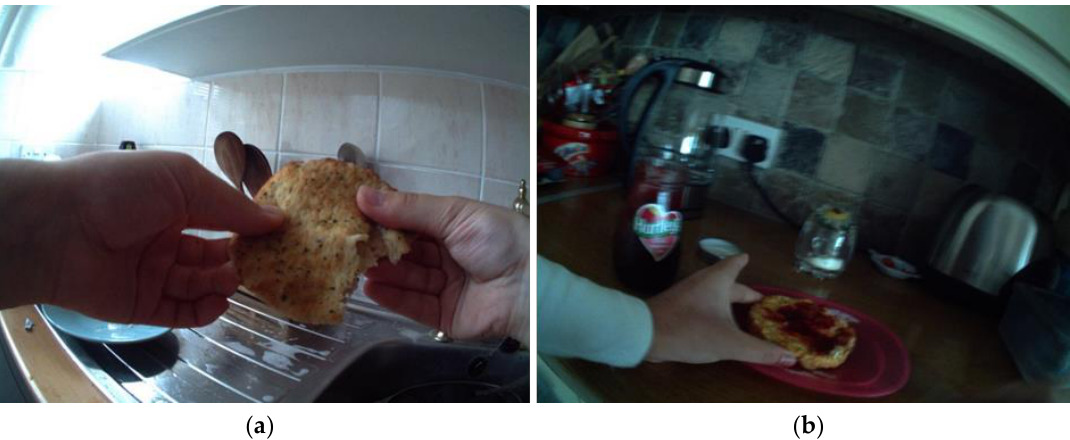
Figure 2. SenseCam images highlighting confusion in whole grain identification (Sasha and Emma) including seeded white bread ( a ) and rice cakes ( b ).